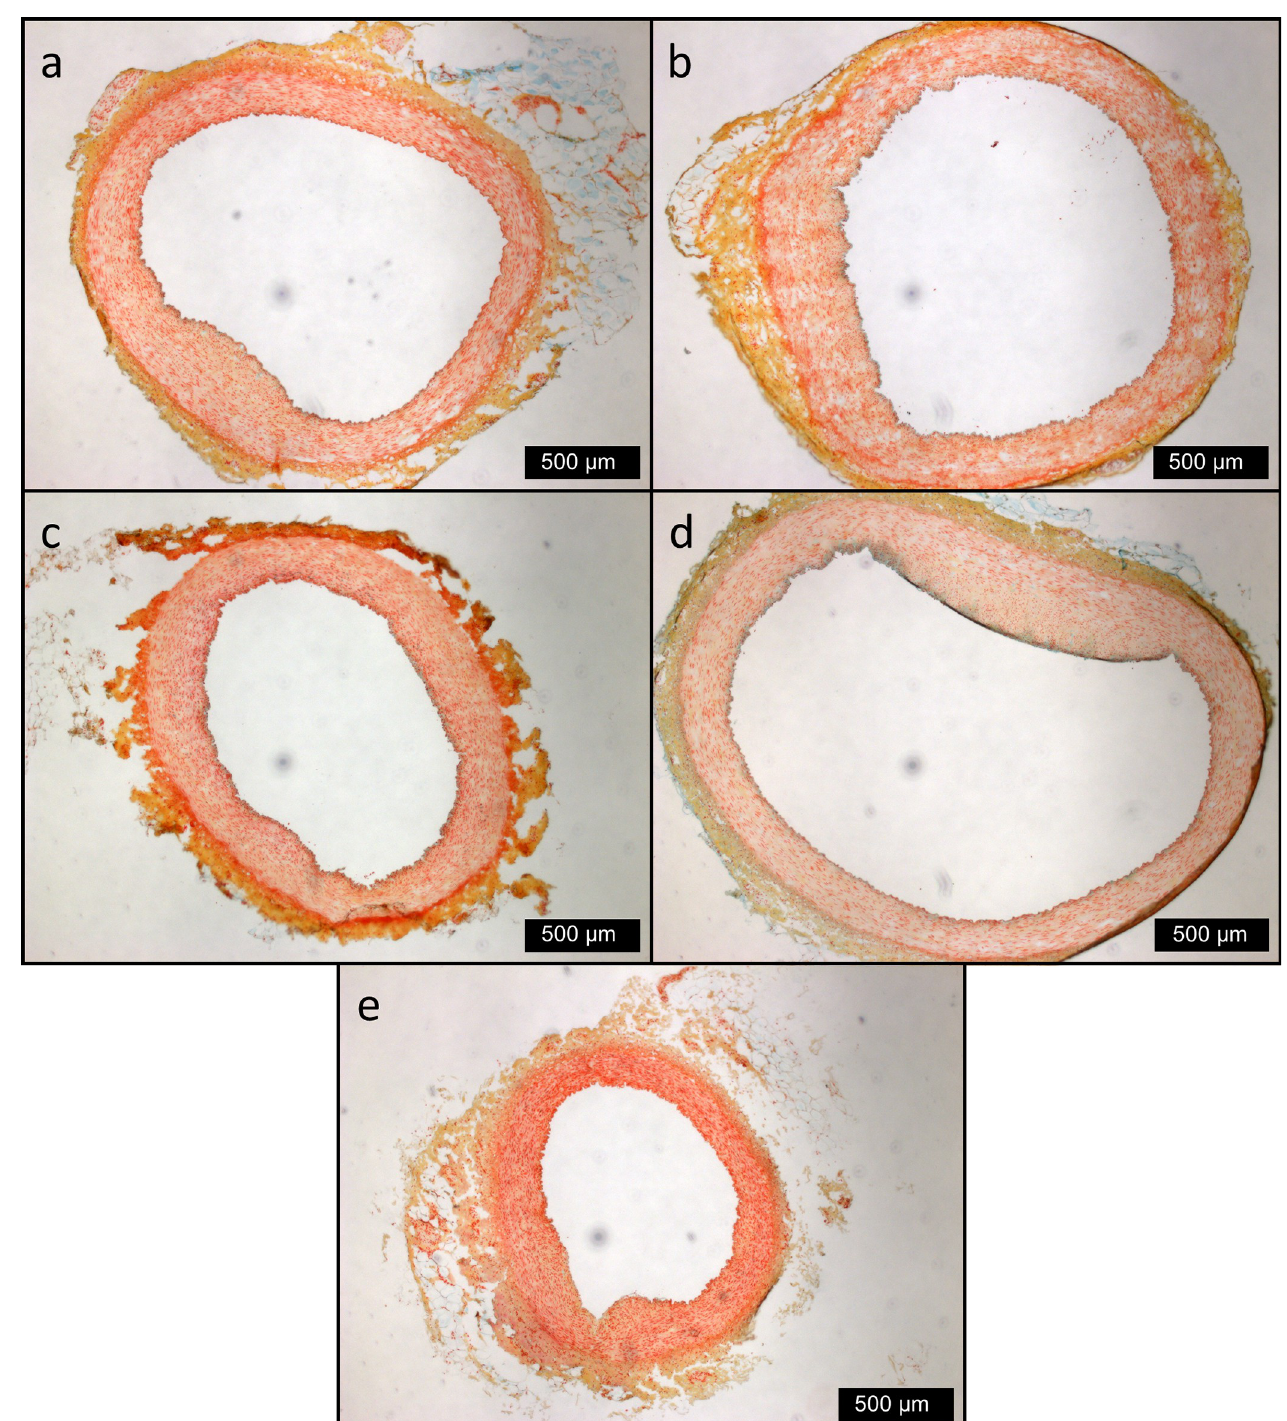
Fig 4. Representative images of LAD cross-sections of all groups. Movat‘s Pentachrome staining (frozen). Scale bar 500 μ m. a BL. b AD. c ADp. d ADi. e CD.